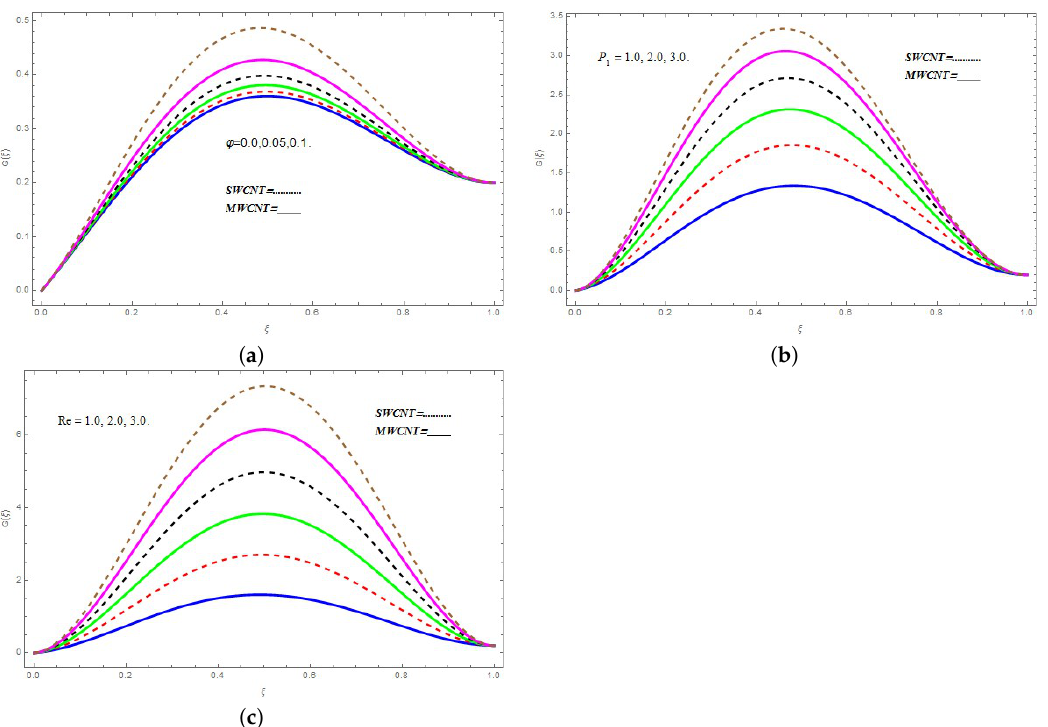
Figure 6. ( a ) Impact of ϕ on G ( ξ ) ; ( b ) Variations in G ( ξ ) under different values of P 1 ; ( c ) Impact of Re on G ( ξ